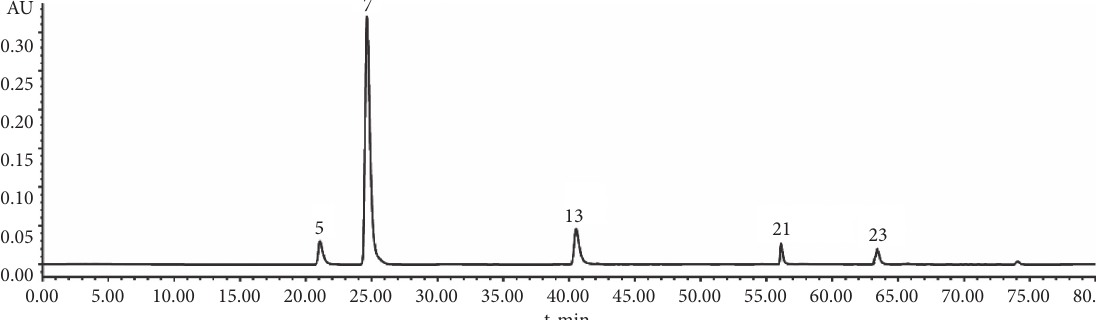
Figure 3: The HPLC fingerprint of mixed reference solution. Vanillic acid ( P5 ), puerarin ( P7 ), ferulic acid ( P13 ), daidzein ( P21 ), and formononetin ( P23